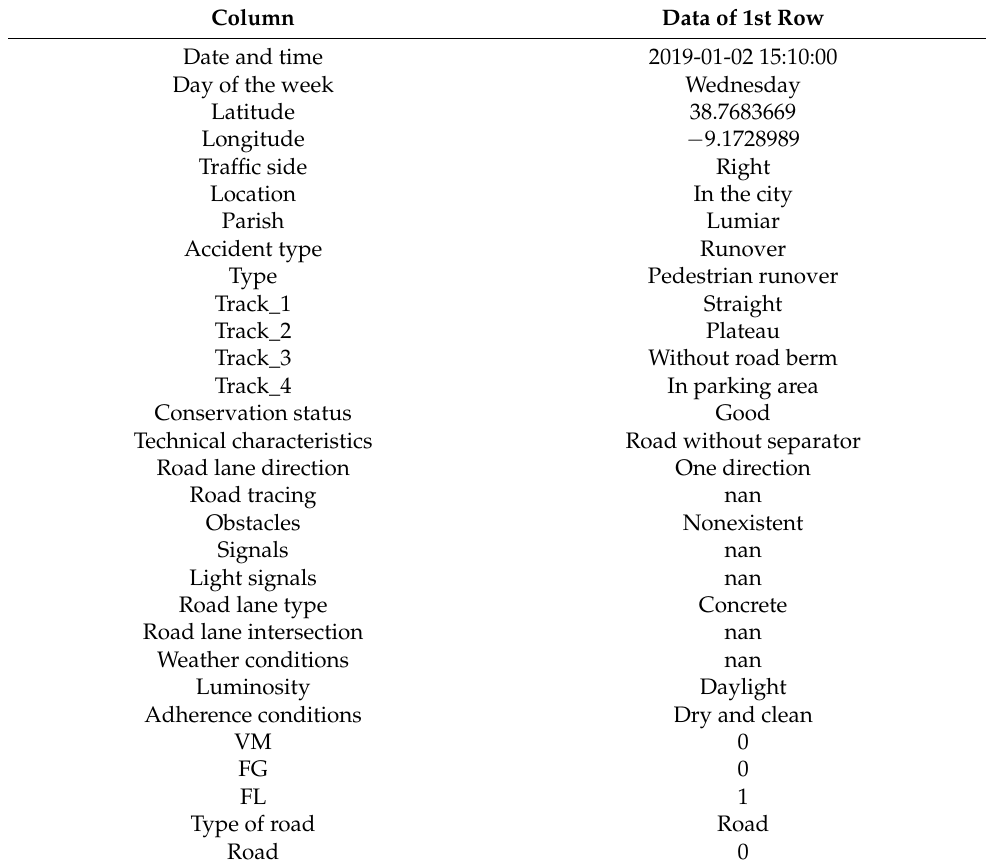
Table 10. Accident data schema after data